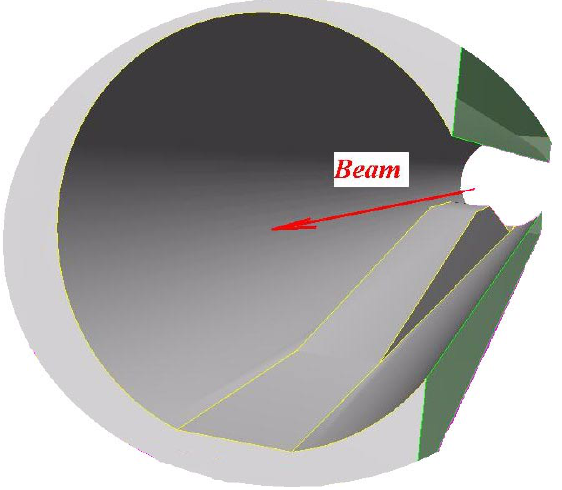
FIG. 1. (Color) PEP-II LER